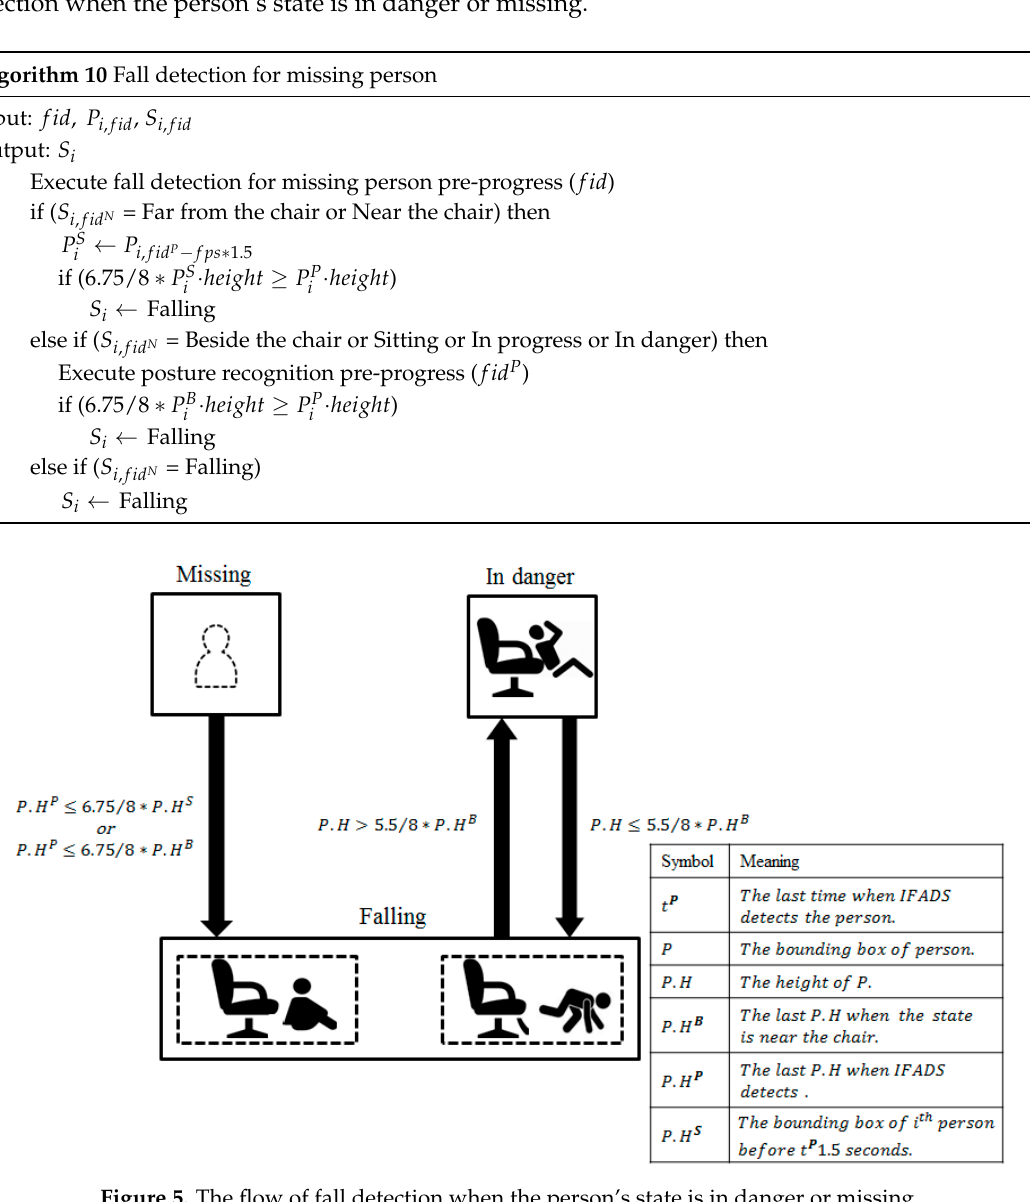
Figure 5. The flow of fall detection when the person’s state is in danger or missing.